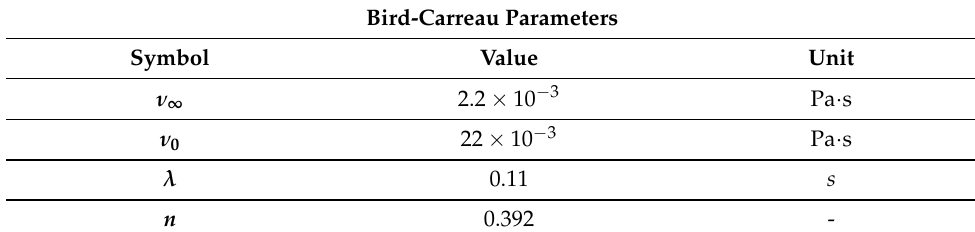
Table 1. Simulation parameters.